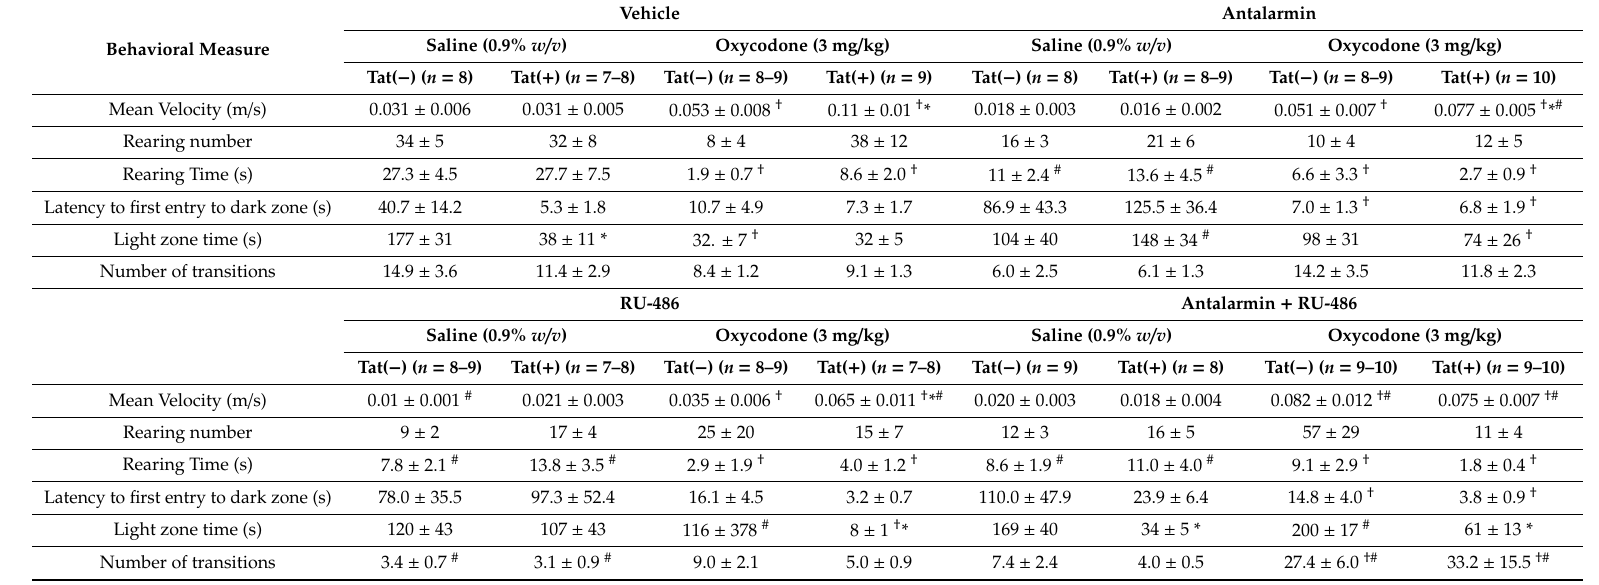
Table 3. Motor measures acquired in an open field and anxiety-like / motor measures acquired in a light-dark transition task from Tat( − ) and Tat( + ) males that were pretreated with the corticotrophin-releasing factor receptor antagonist, antalarmin, and / or the glucocorticoid receptor antagonist, RU-486, prior to administration of saline or oxycodone. * indicates an interaction wherein Tat( + ) mice di ff er from respective Tat( − ) controls. † indicates an interaction wherein oxycodone-administered mice di ff er from respective saline-administered controls. # indicates an interaction wherein the denoted group di ff ers from their respective vehicle controls, p <